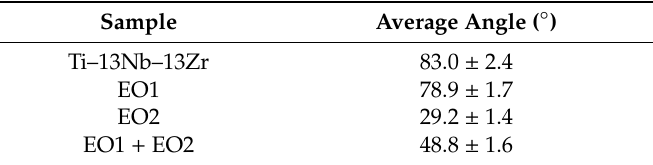
Table 5. Contact angle for the water droplet for the tested specimens.